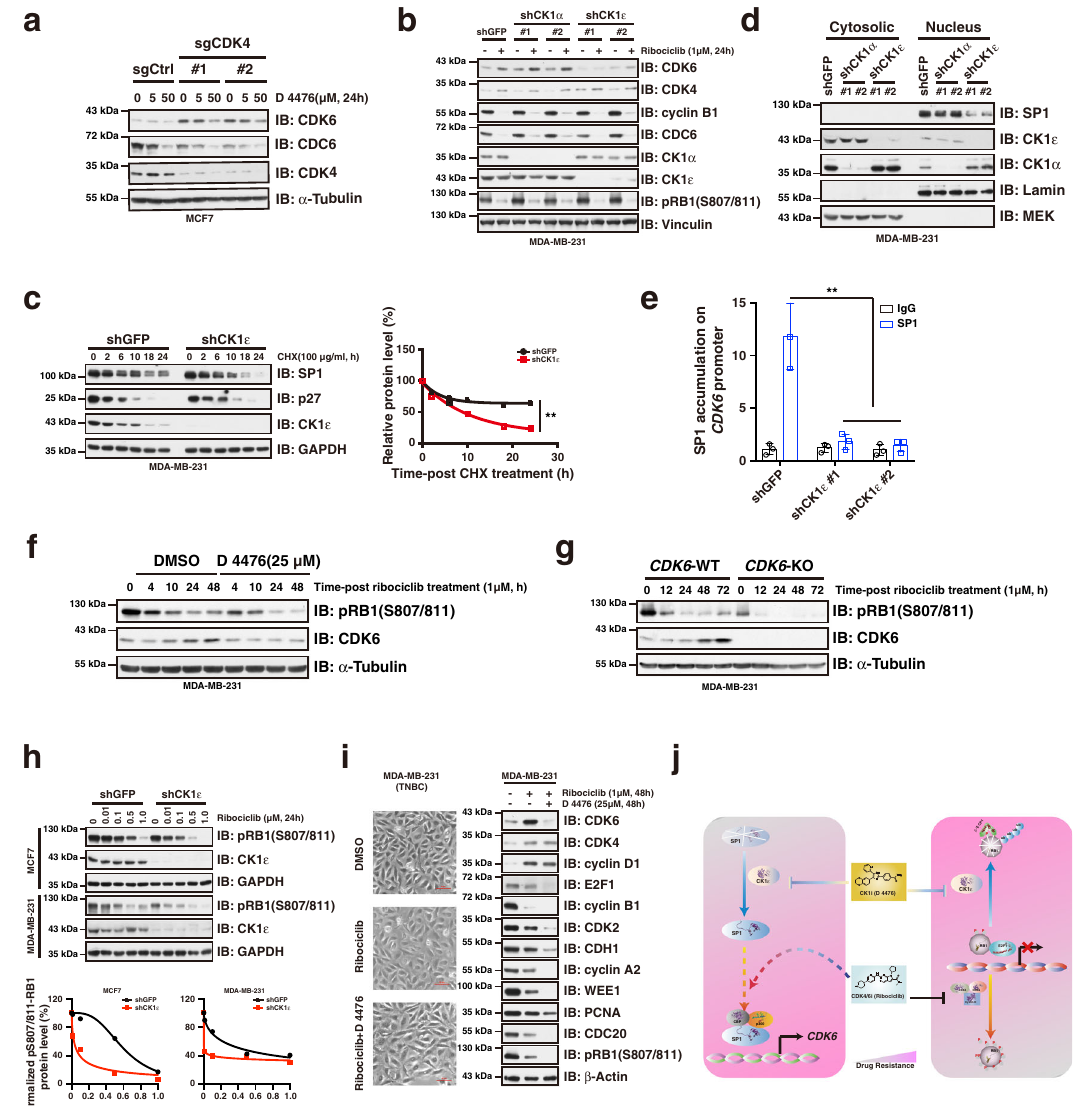
Fig. 5 Suppression of CK1 ε prevents CDK4/6i-induced CDK6 upregulation. a Immunoblot showing that CDK4 -de fi ciency resulted in CDK6 accumulation, which can be ef fi ciently blocked by CK1 ε kinase inhibitor D 4476. b Immunoblot showing that silencing of CK1 ε abolished ribociclib-induced CDK6 accumulation. c Knocking-down of CK1 ε accelerated SP1 degradation. Statistical differences were assessed by two-way ANOVA. ** P < 0.01. d Nuclear accumulation of SP1 was signi fi cantly reduced by knocking-down of CK1 ε . e Knocking-down of CK1 ε diminished accumulation of SP1 on CDK6 promoter region ( n = 3). The P value was calculated by Student ’ s t-test (two-sided). ** P < 0.01. f Treatment of MDA-MB-231 cells with D 4476 blocked CDK6 accumulation and potentiated the ef fi cacy of ribociclib on inhibiting RB1 phosphorylation. g CDK6 -de fi ciency potentiated the suppressing ef fi cacy of ribociclib on RB1 phosphorylation in MDA-MB-231 cells. h Knocking-down of CK1 ε sensitized MCF7 and MDA-MB-231 cells to ribociclib treatment. i Combination of D 4476 and ribociclib blocked CDK6 accumulation and enhanced the suppressive effect of ribociclib on cell cycle gene expression in MDA-MB-231 cells. Scale bar: 10 uM. j A schematic diagram showing the molecular mechanisms by which D 4476 synergizes with ribociclib to prevent acquired CDK4/6i resistance. Data are presented as mean values ± SEM. The relevant raw data and uncropped blots are provided in Source